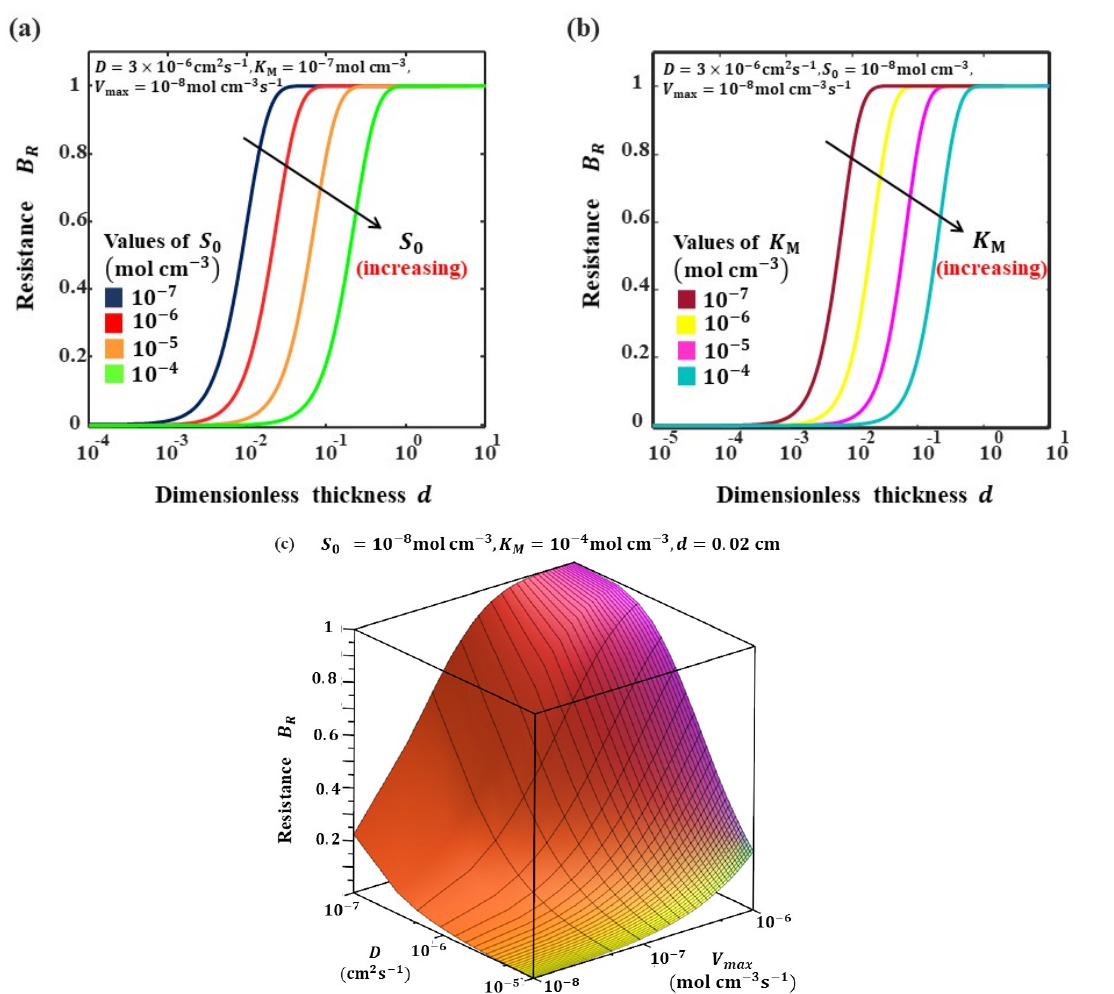
Figure 4. Variation of biosensor resistance as a function of membrane thickness for various values of ( a ) bulk substrate concentration and ( b ) Michaelis constant and ( c ) three-dimensional represen- tation of variation of biosensor resistance for various values of diffusion coefficient, and maximum catalytic rate.